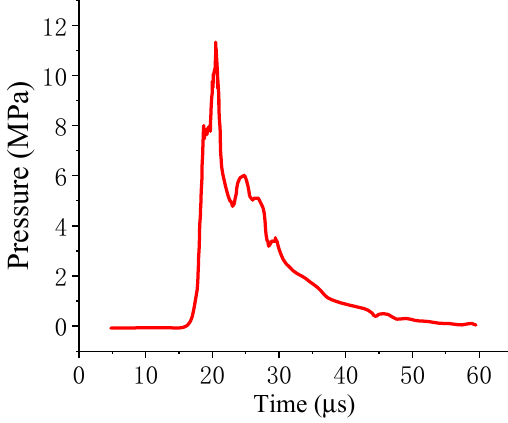
Figure 10. Pressure and time curve of the blast wave.